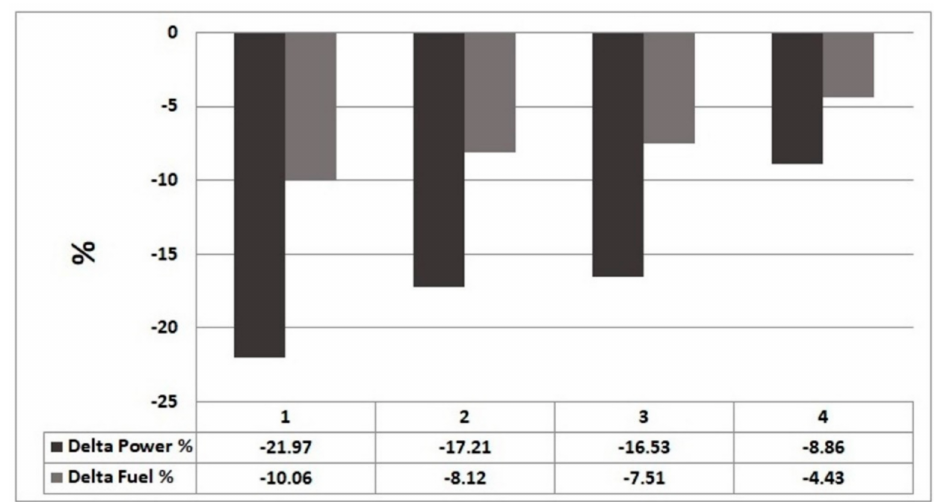
Figure 27. % Delta for power output and fuel demand.